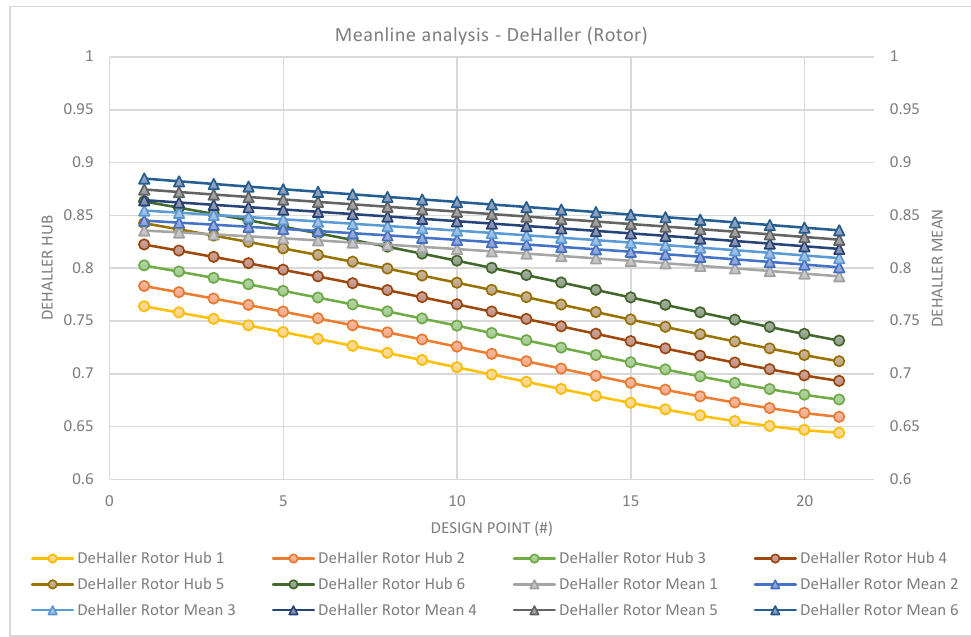
Figure 15. Meanline analysis—DeHaller number (Rotor).